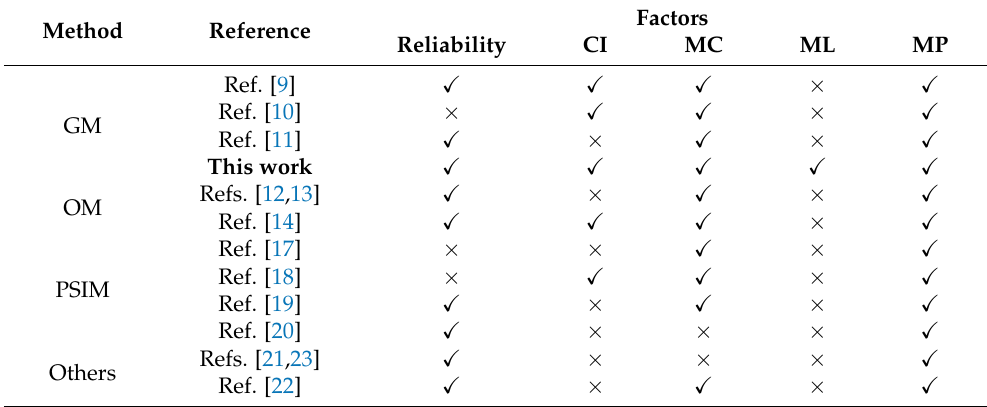
Table 1. Comparison of recent